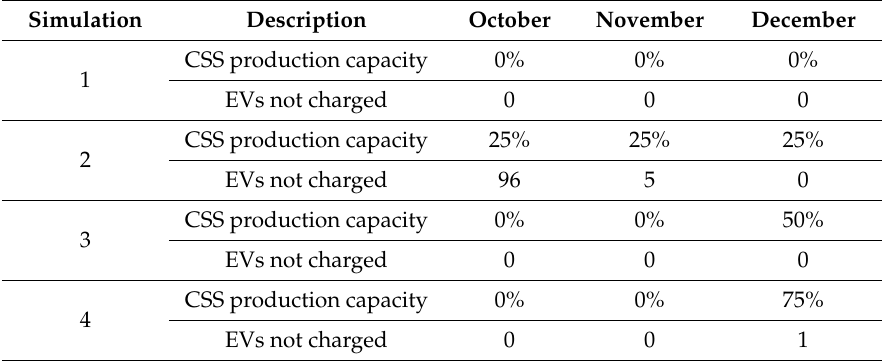
Table 4. Overall system monthly simulation with multiple CSS operational scenarios. Simulation Description